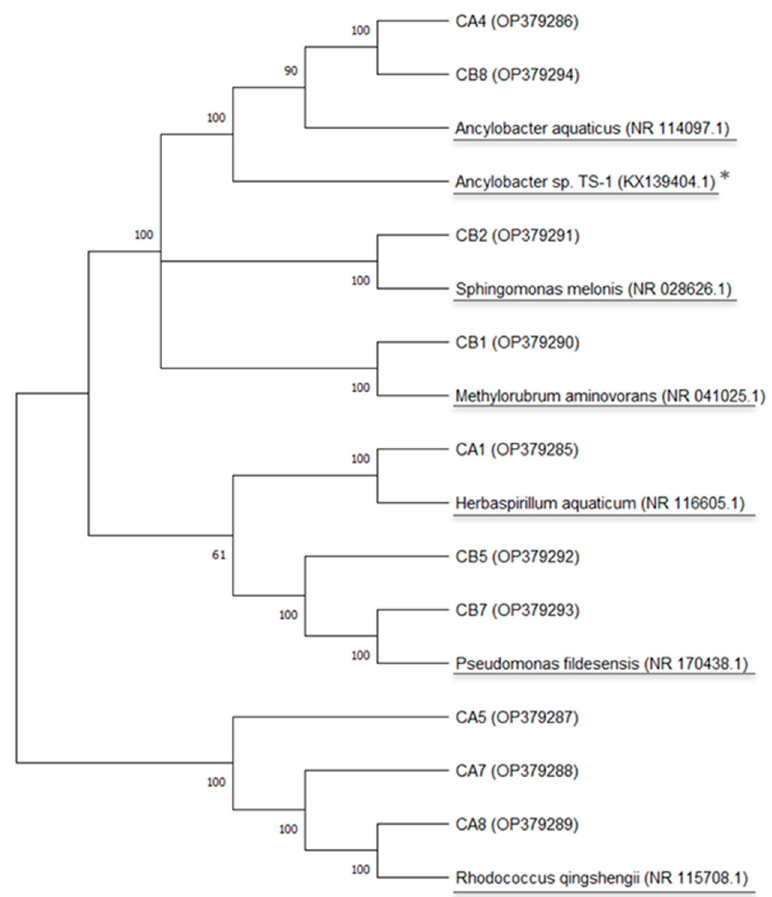
Figure 6. Neighbor-joining phylogenetic tree based on the 16S rRNA sequences of the isolates obtained from cathodes. Reference sequences retrieved from GenBank (underlined) were added for comparison. Genbank number in parentheses. Bootstrap values (1000 replicates) are shown at the tree nodes. (*) The microorganism Ancylobacter TS-1 was previously isolated from the same site where sediments were